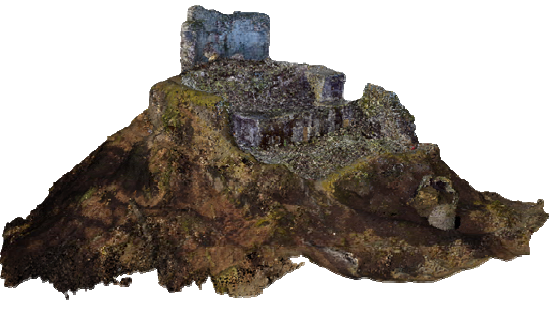
Figure 2 : Overview of the point cloud of the castle and its